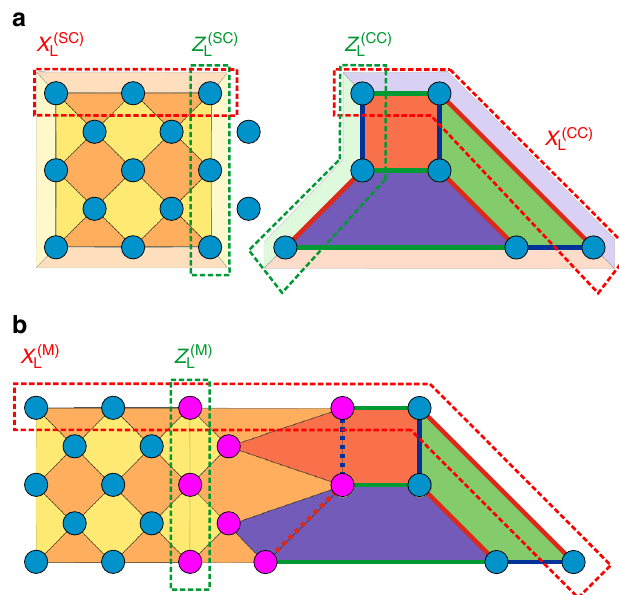
Fig. 2 Lattice surgery between a surface and a color code. a Examples of a surface code (SC) and a color code (CC) with distance 3 de fi ned on lattices with open boundaries. Different types of boundaries are color coded. Qubits are located on vertices depicted in blue. While plaquettes in the surface code correspond to X -type (yellow) and Z -type (orange) stabilizers, respectively, each plaquette in the color code corresponds to both X - and Z - type stabilizers. Representative logical Pauli operators X L and Z L are depicted by dashed lines and are tensor products of single-qubit X and Z operators, respectively. b Merging stabilizers are (orange) plaquette operators acting as Z on qubits along the boundary and ancillas (all shown in fuchsia). Measuring all merging stabilizers projects onto a joint eigenstate of the two logical operators Z SC ð Þ and Z CC ð Þ . While Z -type L L stabilizers remain unaffected, the procedure merges X -type stabilizers and logical X operators, respectively, as displayed. In particular, the resulting merged code, labeled by M, encodes only one remaining logical qubit de fi ned by Z ð M Þ and X ð M Þ . Note that the geometry of the underlying codes L L can be chosen to fi t the geometry of a speci fi c computational architecture. Note further that there are many different layouts realizing the same error correction code and this fi gure merely shows a common variant